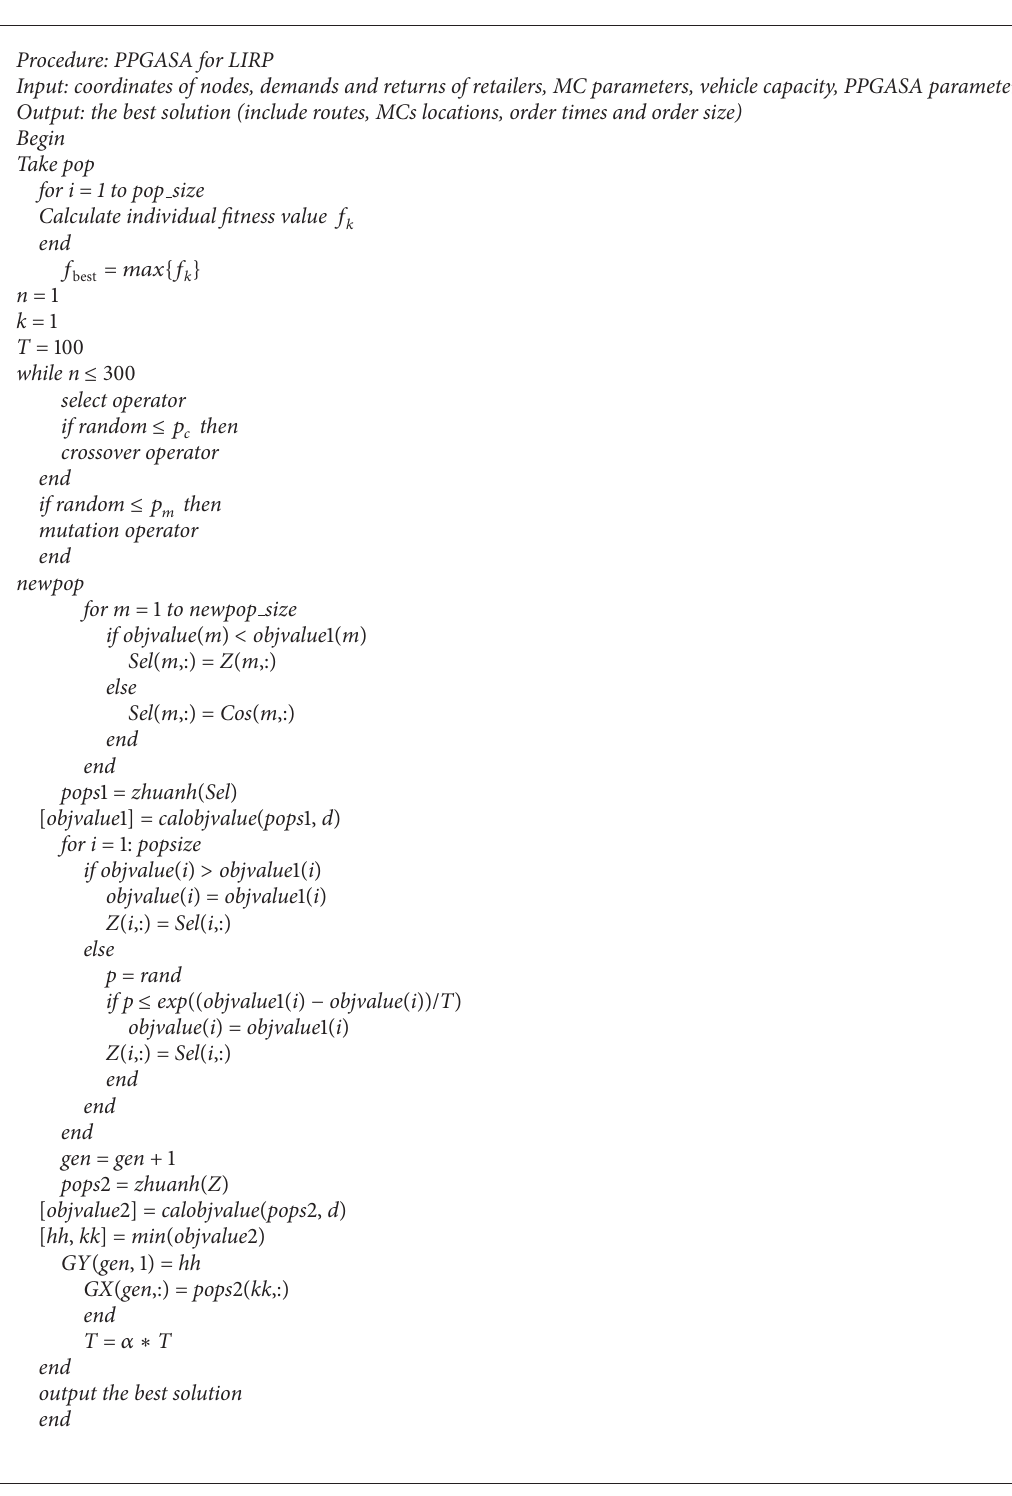
Pseudocode 1: Pseudocode of the proposed